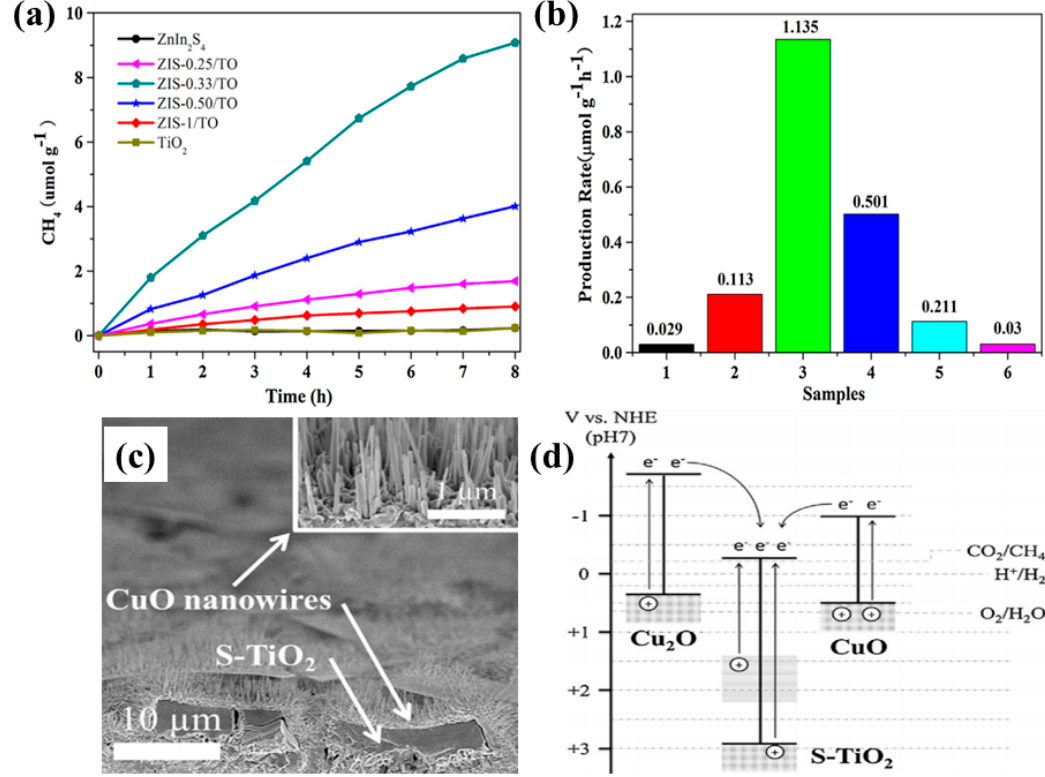
Figure 13. ( a ) Photocatalytic CH 4 evolution and ( b ) production rate employing various samples with varied ratios of ZnIn 2 S 4 to TiO 2 (taken with permission from [75]). ( c ) SEM image of Cu 2 O / S-TiO 2 / CuO p-n-p nanostructure, and ( d ) band gap diagram with the mechanism involved in the conversion of CO 2 to CH 4 (taken with permission from [76]).